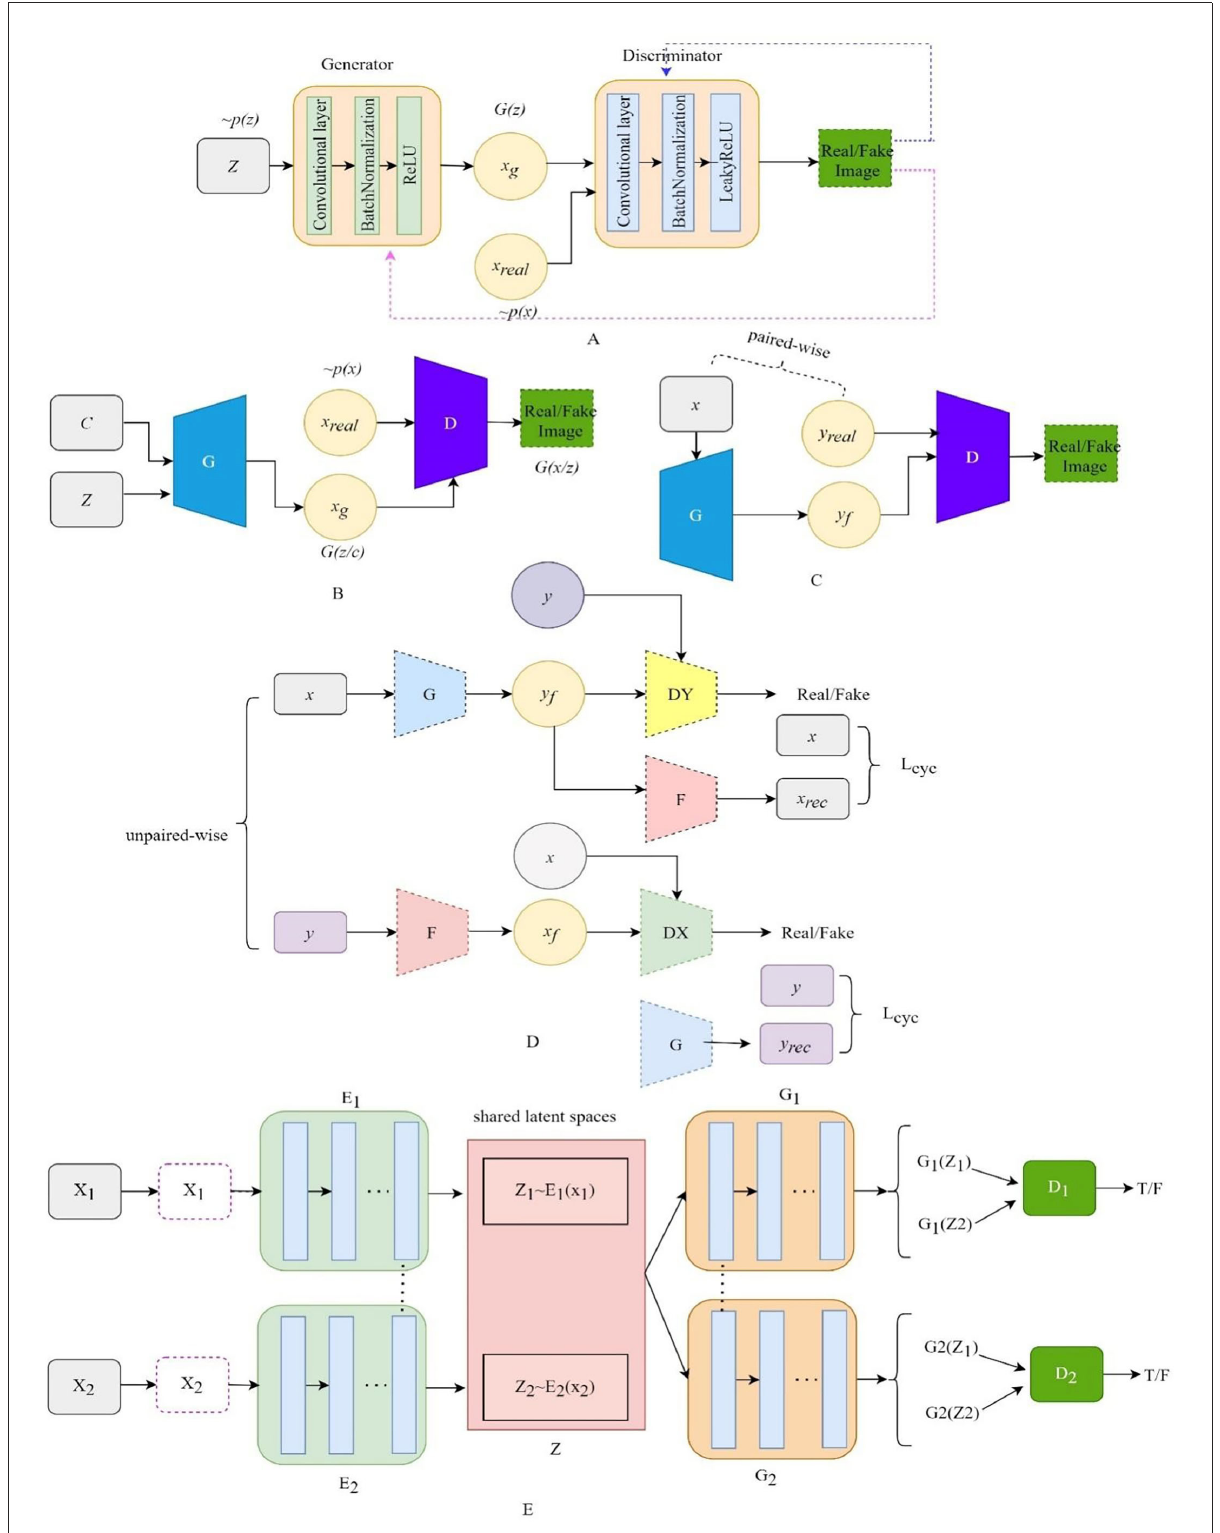
FIGURE2 The architecture of the variant GANs. (A) The architecture of DCGAN, (B) the architecture of CGAN, (C) the architecture of Pix2Pix, (D) the architecture of CyclGAN, and (E) the architecture of